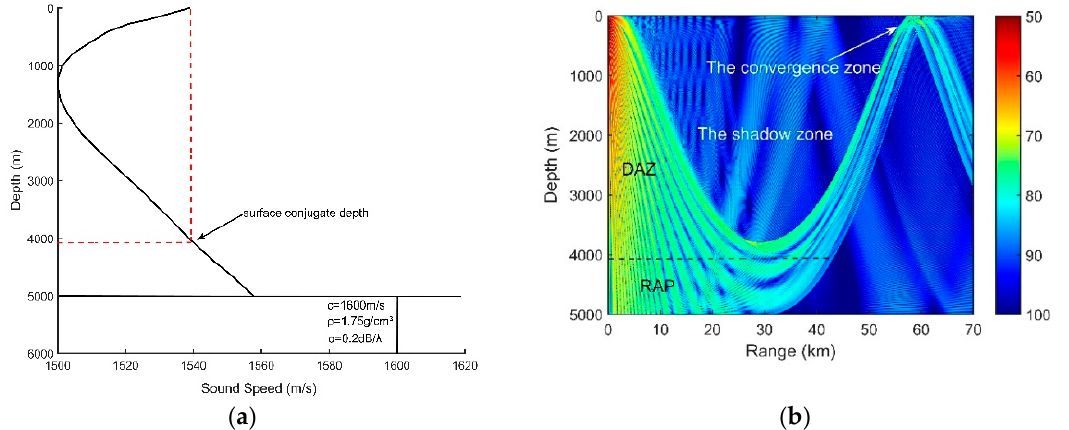
Figure 1. ( a ) Munk sound speed profile; ( b ) Transmission loss for a source at 100 m depth at the frequency of 150 Hz.